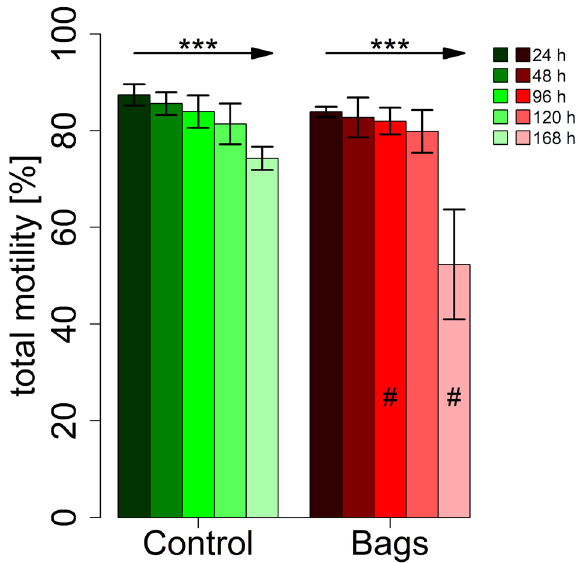
Figure 3. Percentage of motile spermatozoa (%) in sixteen pooled ejaculates (4 × 4 ejaculates) from 16 mature Pietrain boars after 24, 48, 96, 120 and 168 h of semen storage. Correlation between time and motility: